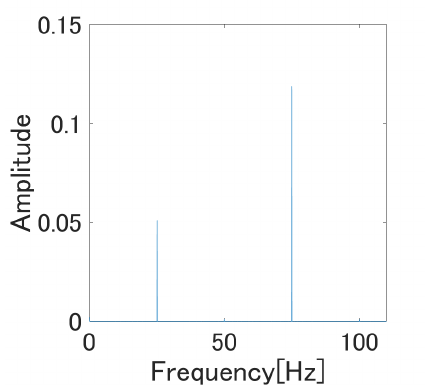
Figure 19. Result of FFT analysis on the output signal of the response for 25 Hz reference.